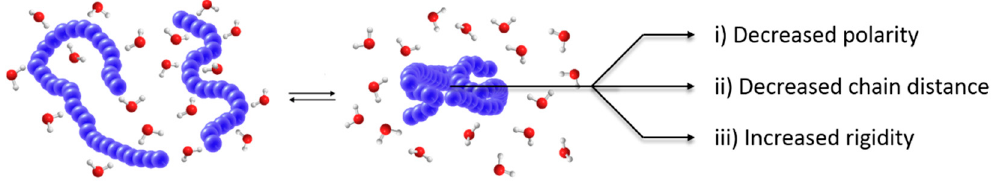
Figure 8. Schematic representation of a polymer phase transition in aqueous solution and a description of the significant changes in the local environment of the polymer. Adapted from [81].